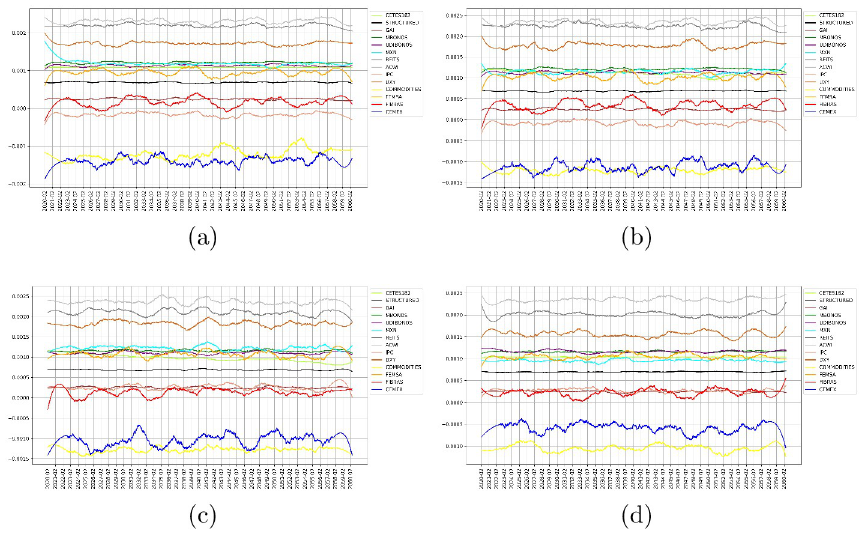
Fig 3. Filtered expected returns. (a) Figure at top left: results obtained with EGARCH models. (b) Figure at top right: results obtained with the GJR model. (c) Figure at bottom left: results obtained with the GARCH model. (d) Figure at bottom right: results obtained with SBBS